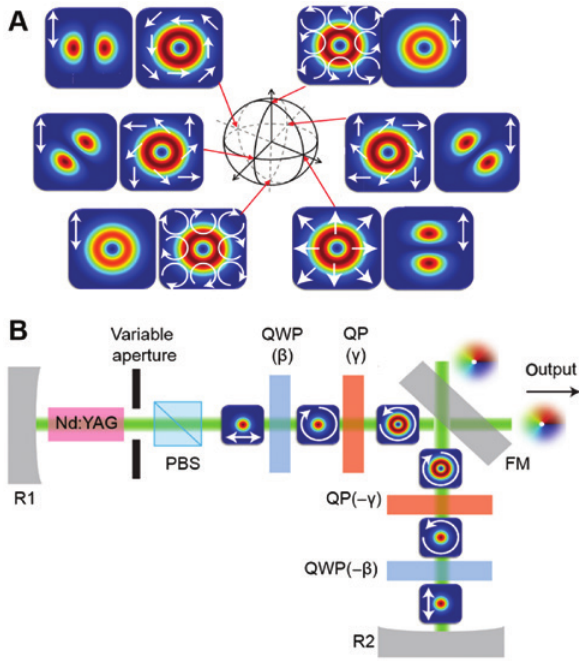
Figure 8: Vectorial vortex lasing. (A) Vertex beams of various polarization described by the higher- order Poincaré (HOP) sphere. The white arrows show each beam’s polarization. These beams have different spatial distribution after passing through a linear polarizer oriented in the vertical direction, as depicted by the double-ended arrows. (B) Conceptual description of the experiment setup where mirrors R1 and R2 together form the Fabry-Perot lasing cavity. The selection of OAM relies on the spin to orbital AM coupling provided by the q-plates. Changing the orientation angle ( β ) of the first quarter-wave plate (QWP) and the rotating angle of the first q-plate (QP) results in different OAM polarization states on the HOP sphere. An additional QWP and a second QP are also required to convert the vector OAM mode into a linearly fundamental Gaussian mode. Thus, the polarization and OAM mode at each position repeat themselves over a cavity round trip. Reprinted from Ref.